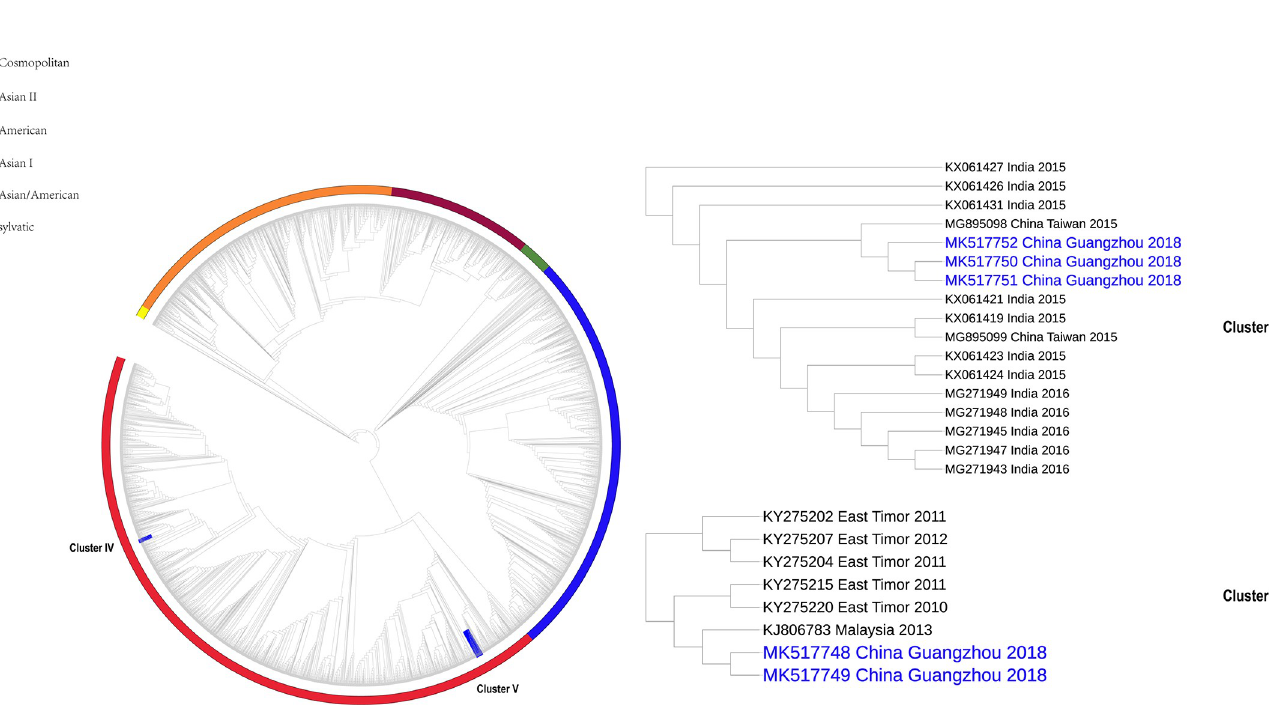
Fig 3. Maximum likelihood tree for global dataset reconstruction of DENV-2. The maximum likelihood tree result of DENV-2 is shown in the figure. The sample sequence clusters under different branches, and the blue blocks labeled in the branches in the figure are clusters of sample sequence clusters. Different color blocks outside the branches represent different